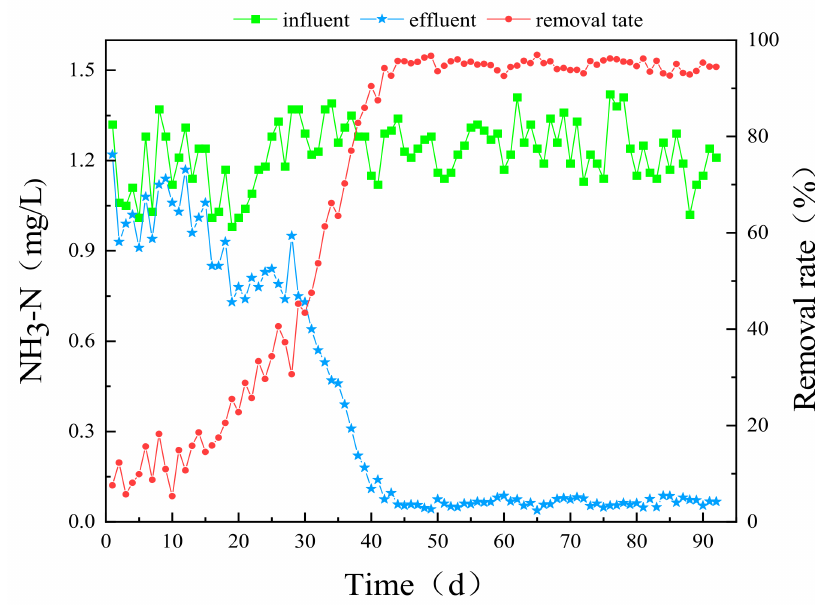
Figure 4. Ammonia use reduction in aeration biofilter